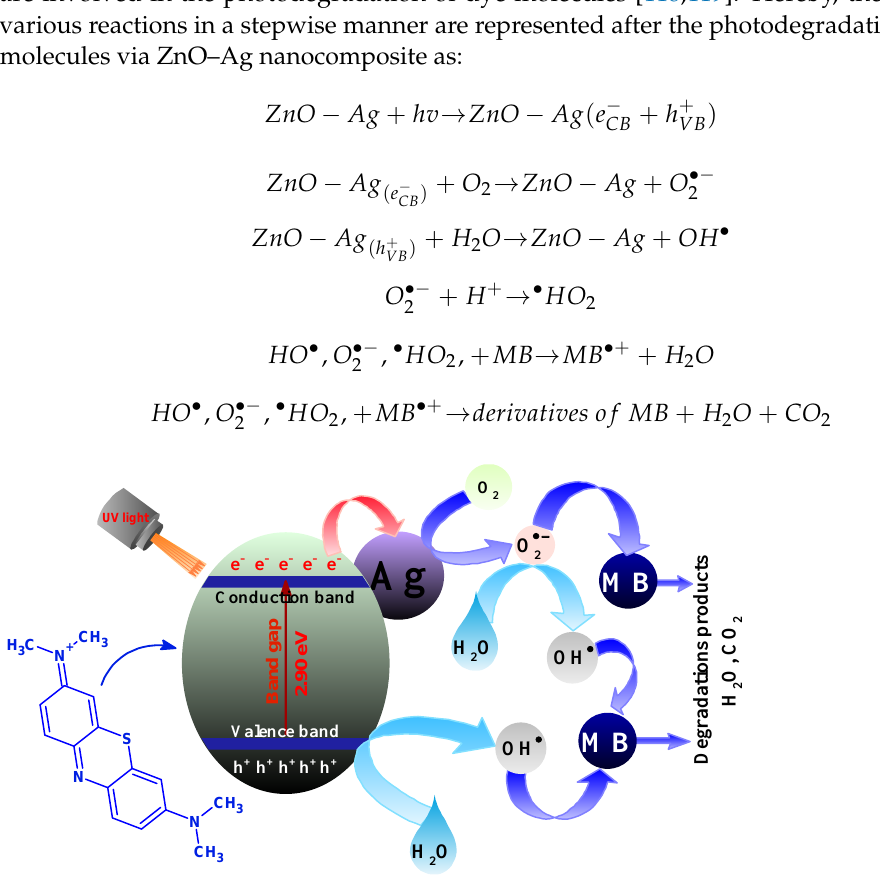
Figure 13. The possible mechanism of photocatalytic degradation of MB dye using ZnO – Ag nanocomposite under UV light irradiation.